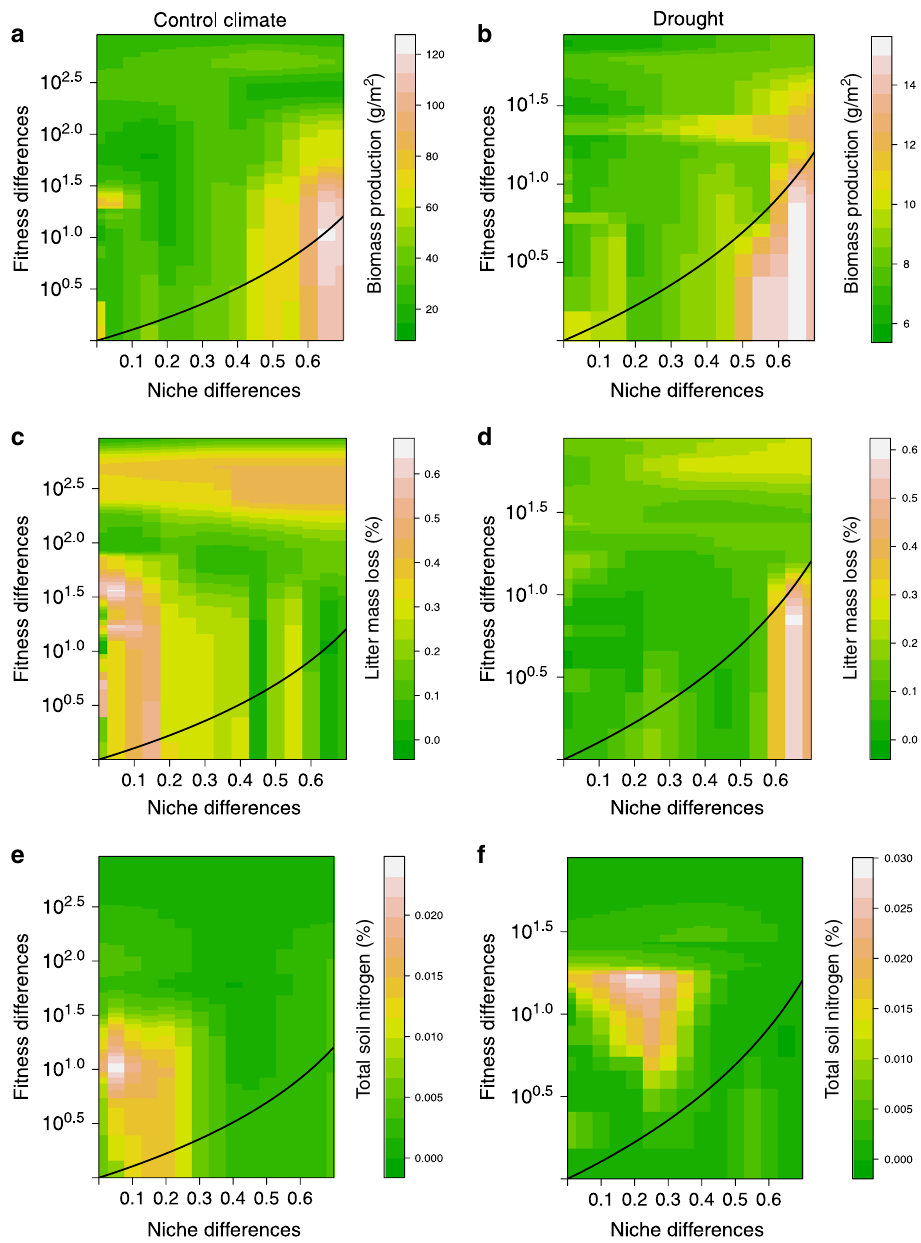
Fig. 3 Relationship between the degree of stability of coexistence and the levels of multiple functions. Biomass, upper two panels ( a and b ); litter decomposition, middle two panels ( c and d ); total soil N, lower two panels ( e and f ) under control climate conditions (left panels), and drought (right panels). The heat map represents the level of functioning estimated for a given species pairs, using the approach of (20). Greener colors represent low functioning while brownish to white colors represent higher functioning. The solid black line indicates whether the conditions for coexistence are met ( ρ < κ j κ , where species j is the fi tness superior) and separates the coexistence from the competitive exclusion region. Mantel tests, following i Benjamini – Hochberg correction for multiple comparisons, showed that the excess of niche differences for a species pair (i.e., their distance from the coexistence line) was signi fi cantly related to their predicted biomass and the predicted litter decomposition under drought but not under control climate conditions or soil nitrogen availability. For a graphical representation of observed pairwise niche and fi tness differences (Supplementary Fig.